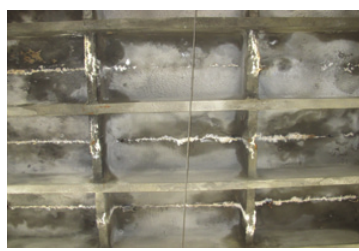
fig. 16. Locations of samples P1 and P2 for bridge over the Daugava on bypass A5